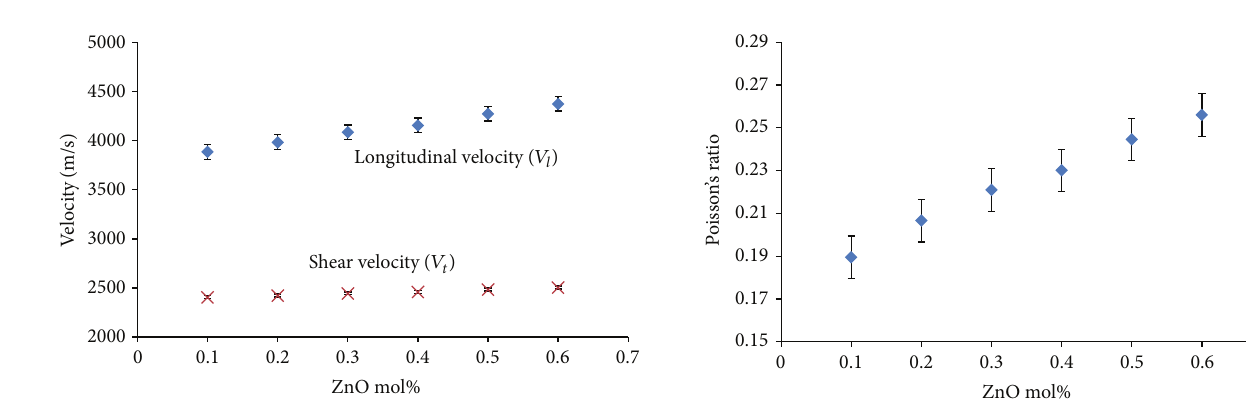
Figure 5: Variation of Poisson’s ratio versus ZnO mol%.